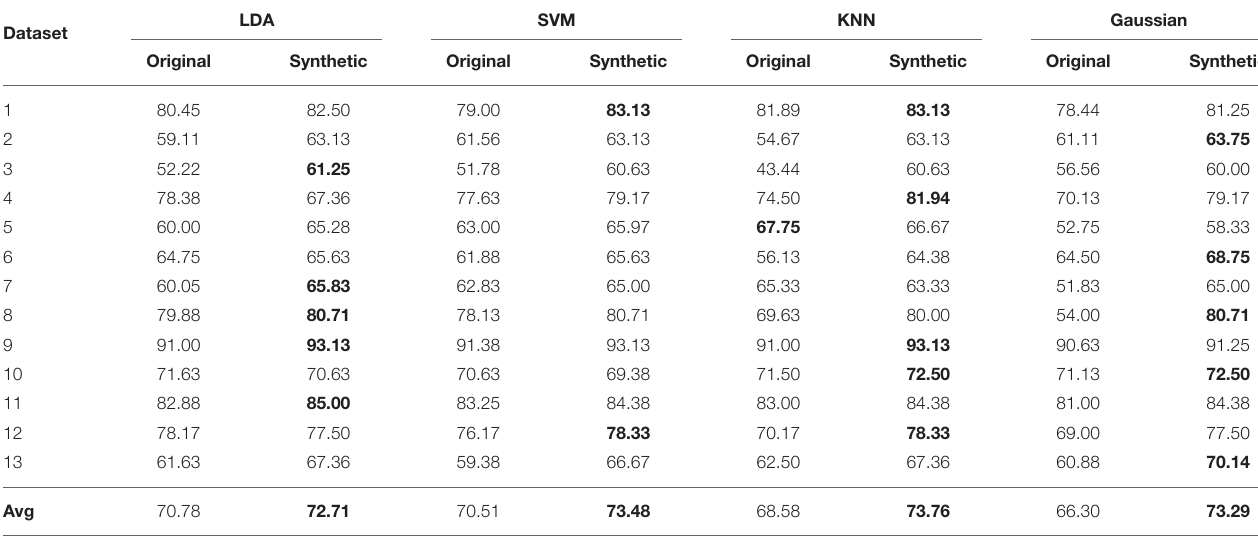
TABLE 2 | Comparison of classification performance for synthetic motor imagery (MI) assessment when (a) the classifier is trained and tested with original data using 100-fold cross-validation (95% training set and 5% testing set) for baseline accuracy estimation (denoted as Original ), and (b) the classifier is trained with synthetic data and tested with all of the original data (denoted as Synthetic